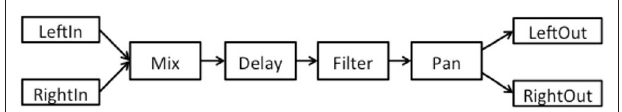
FIGURE 3 | An audio computation